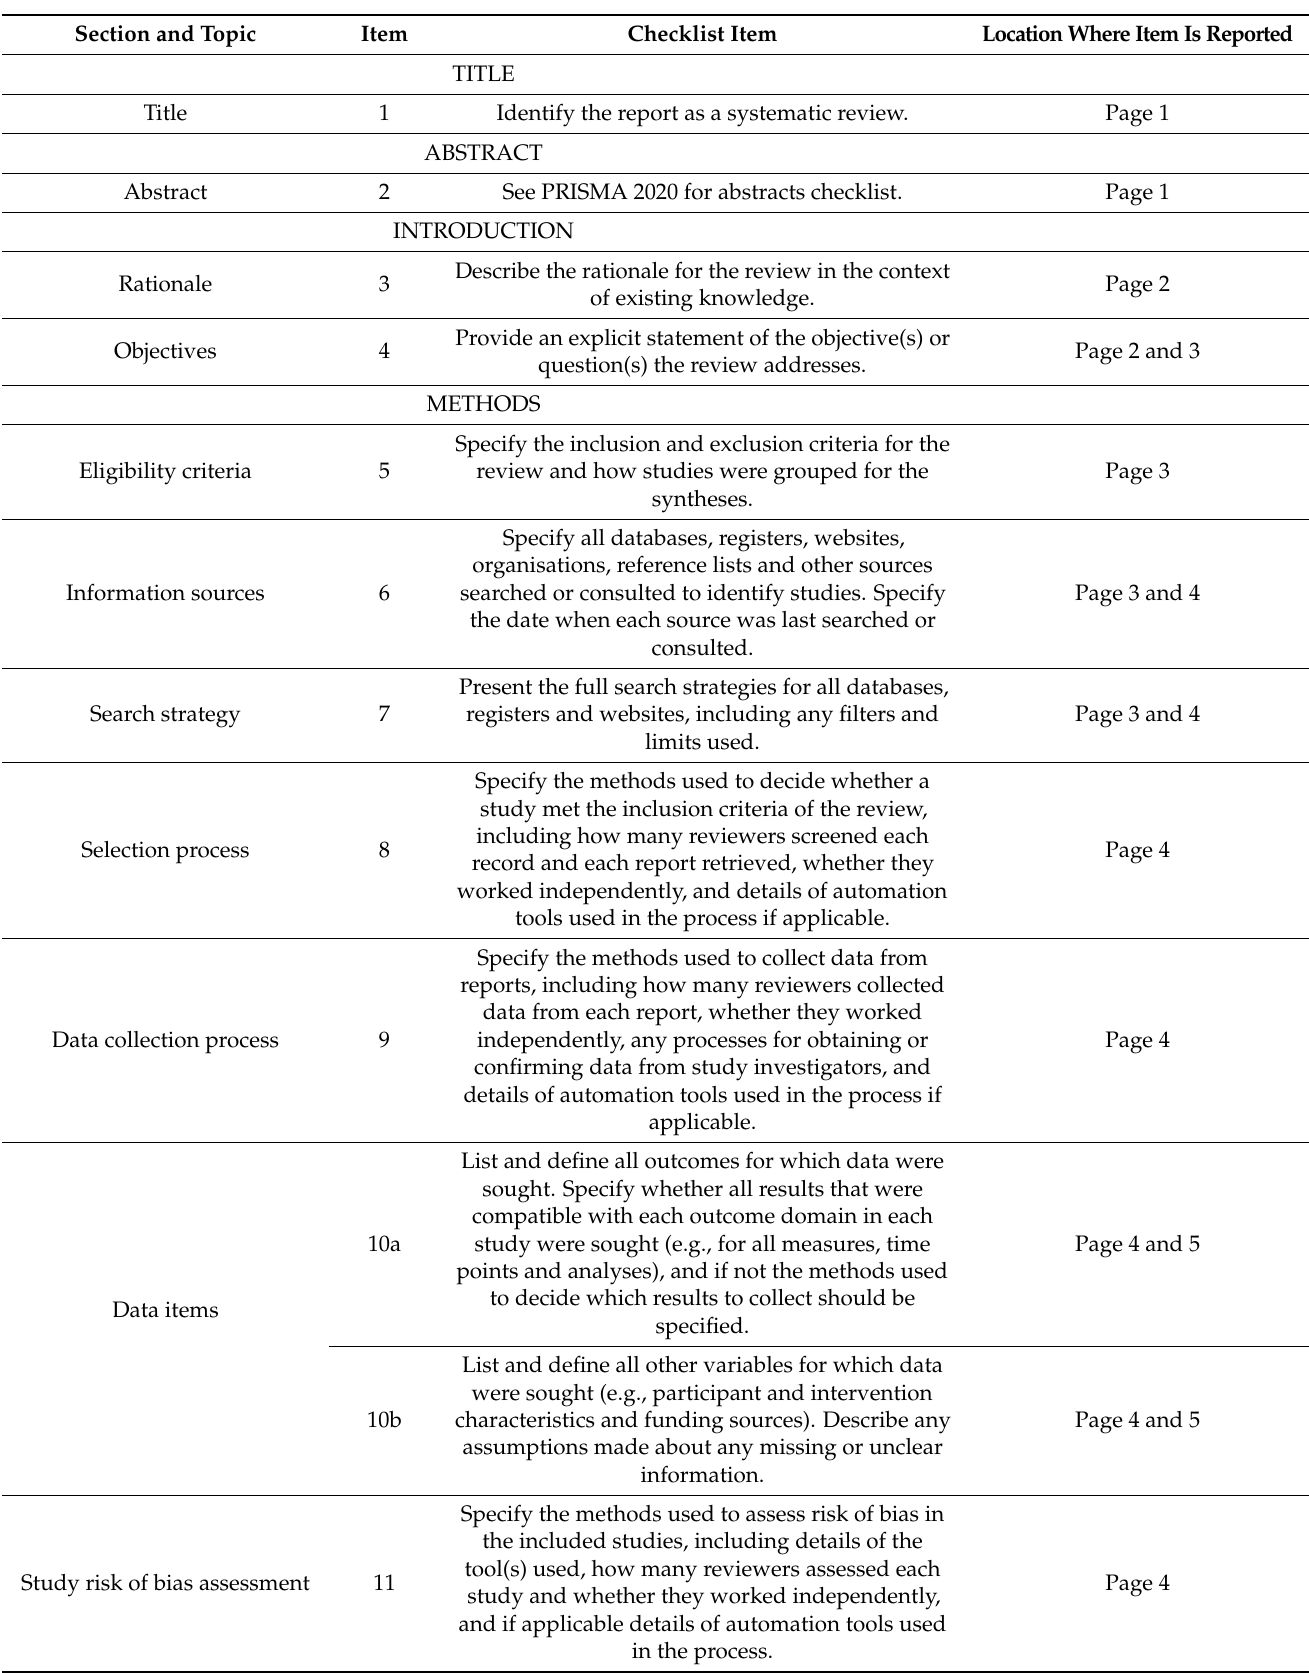
Table 1. PRISMA checklist used to undertake the